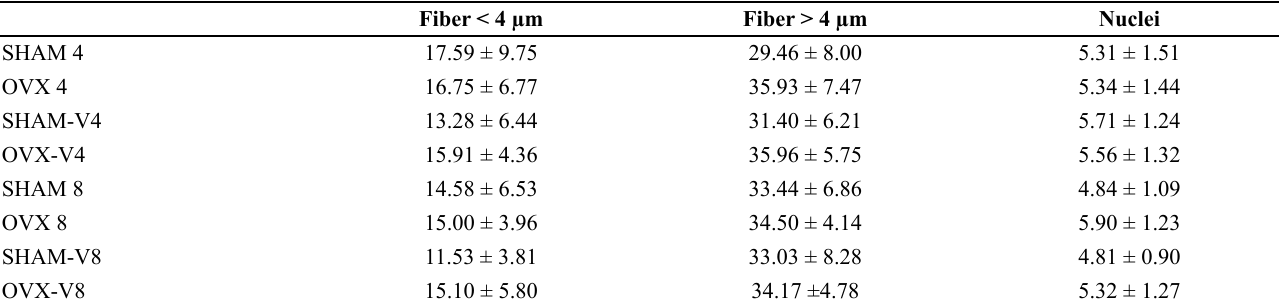
Table 3. Count of nerve fibers smaller in diameter and larger than 4 μm, and of Schwann cell nuclei, of the sciatic nerve of Wistar rats